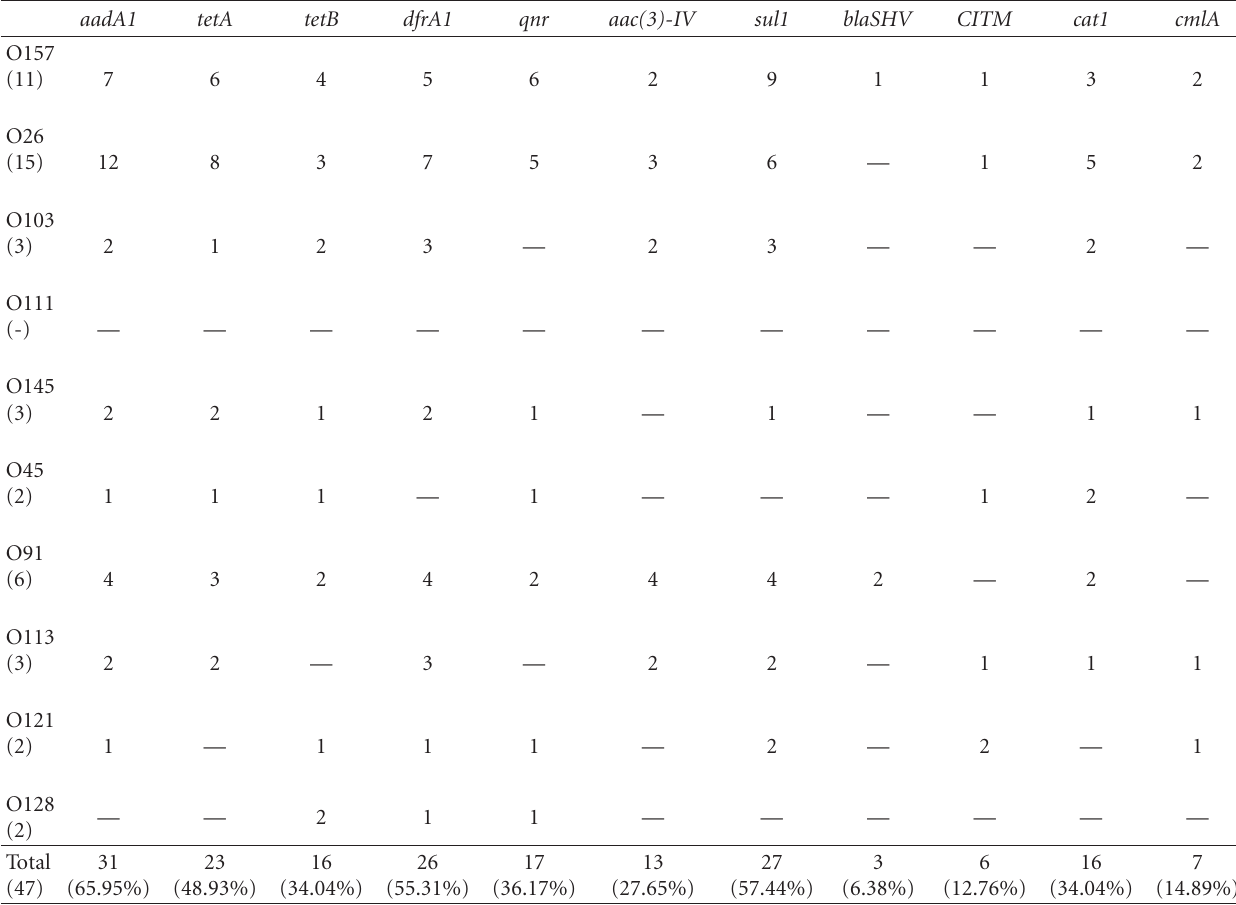
Table 8: Distribution of antimicrobial resistance genes in Shiga toxin-producing Escherichia coli serogroups isolated from bovine mastitis.